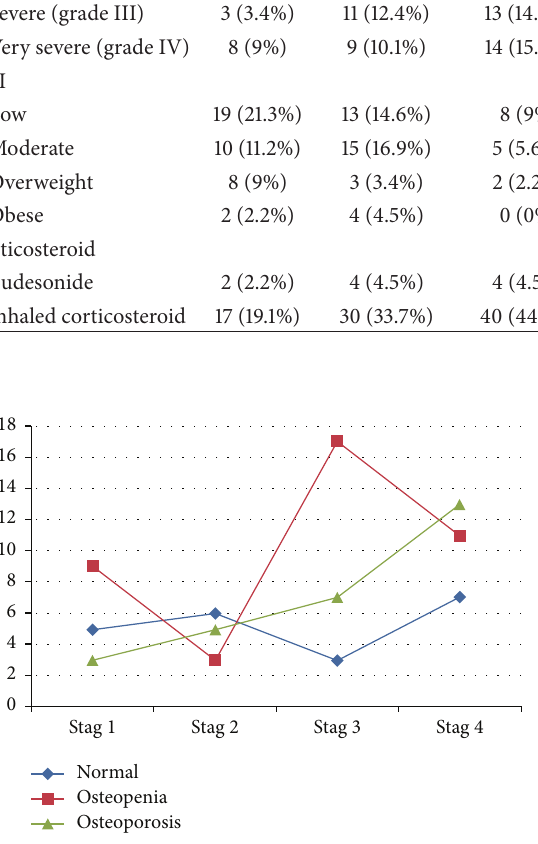
Figure 1: Interaction between osteoporosis in the femoral neck and severity of COPD.